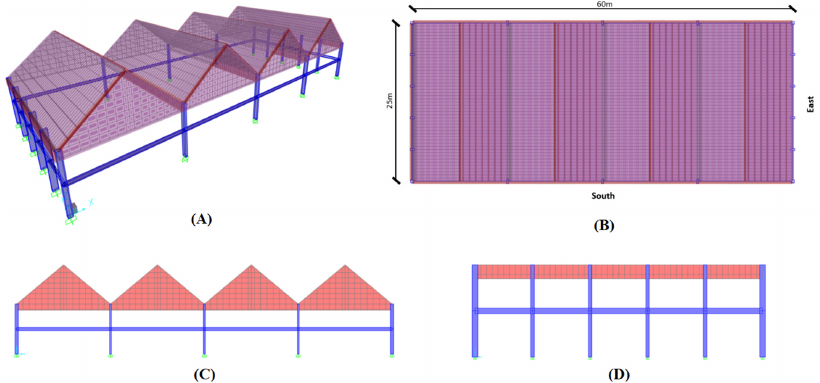
Figure 11. V-type folded plate roof problem: ( A ) 3D view; ( B ) Plan view; ( C ) South elevation view; ( D ) East elevation view. Table 12. Input data for the V-type folded plate roof building.